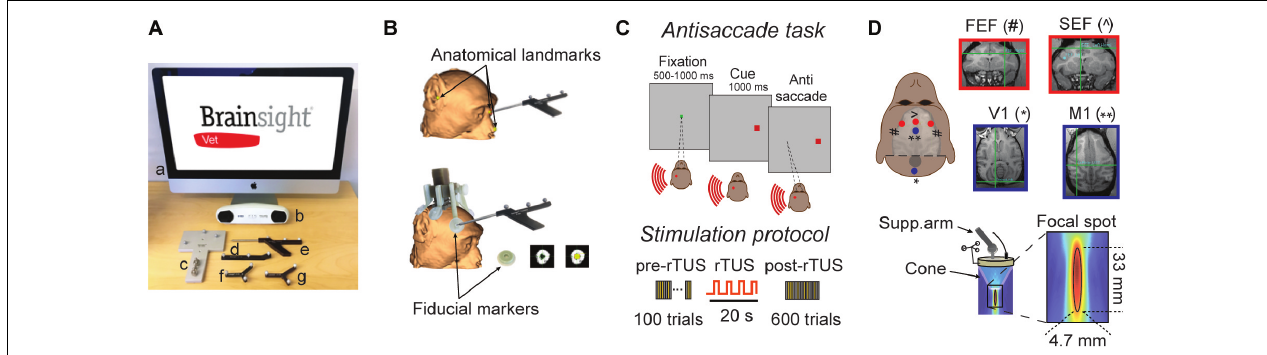
FIGURE 1 | Experimental set-up. (A) List of navigation tools to carry out a monkey registration: Brainsight computer (a), position sensor (b), calibration block (c), tool tracker (d), navigation pointer (e), subject tracker (f), and transducer tracker (g). (B) Subject registration. Top: registration can be based on facial landmarks which are defined as the bridge of the nose, the tip of nose and the notch above the tragus of the ears. Bottom: In the present study, we used fiducial markers which are fixed to the headpost of the subject resulting in higher co-registration accuracy between the subject and the MRI scan. These fiducial markers create hyperintensities on the MR images that are easily distinguishable. (C) Antisaccade paradigm. The animal starts the trial by fixating a central spot (green square) for 500–1000 ms. A peripheral cue (a red square at 16 degrees of eccentricity) is then presented either at the left or right of the visual field on the horizontal meridian for 1000 ms. The animal is rewarded by making an eye movement to the opposite location of the peripheral cue (antisaccade). The brain area stimulated by rTUS is indicated by the red circle (here, left FEF). Each animal practices a block of 100 trials before rTUS (pre-rTUS block) and then six post-rTUS trials. Each block contains 100 trials (50 right and 50 left) and lasts on average 5 min. The rTUS train lasts 20 s at a frequency of 10 Hz with stimulation pulses of 320 kHz. (D) Experimental set-up. The ultrasonic transducer is manually guided toward the Region of Interest (ROI) by a neuro-navigation system (Brainsight Vet). The cigar-shaped focal stimulation (bottom panel) targeted the FEF and SEF location [indicated by red dots: FEF (#) ans SEF ( ∧ )]. We also performed sham stimulation sessions by placing the transducer over the primary motor or visual cortex [V1 (*) and M1 (**) indicated by blue dots]. The insets represent the MRI images used to locate ROI (red squares) and control areas (blue squares). The intersection of horizontal and vertical green lines in each quadrant indicates the point at which the focused ultrasound stimulations were